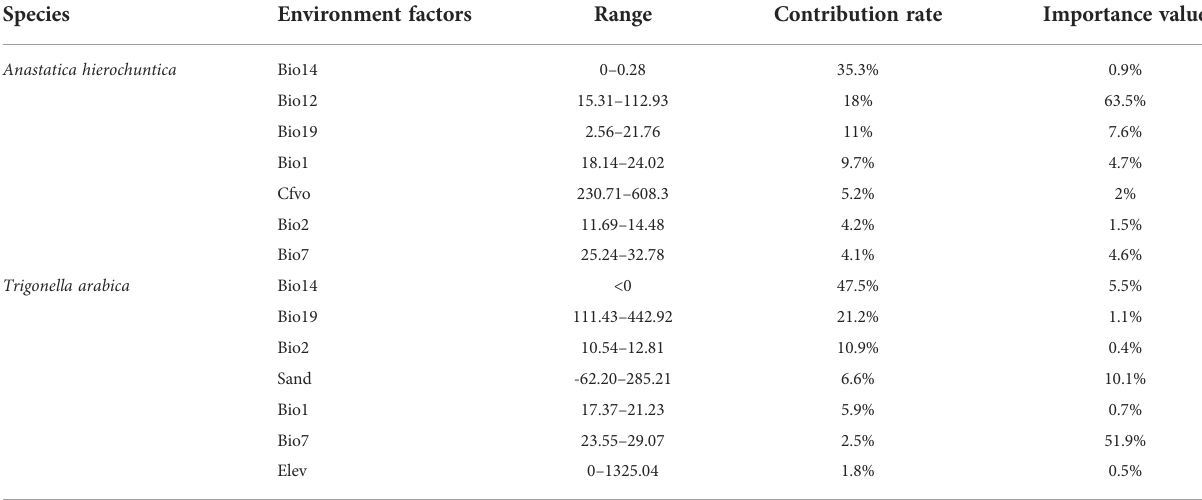
TABLE 5 Contribution of environmental factors to the distribution of ephemeral plants in hot deserts. Species